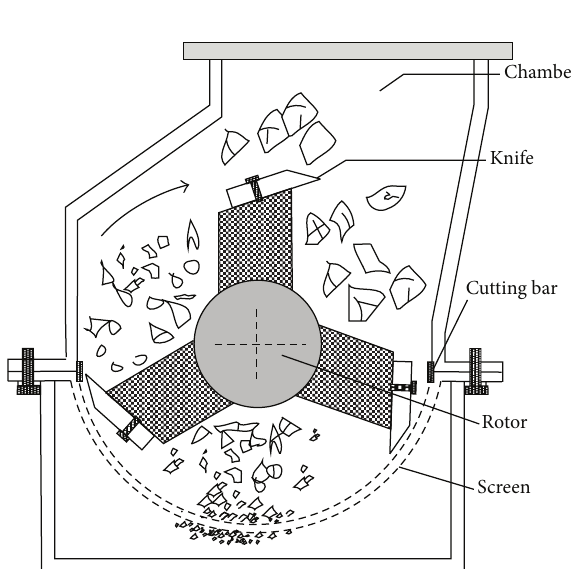
Figure 2: Illustration of a knife mill.